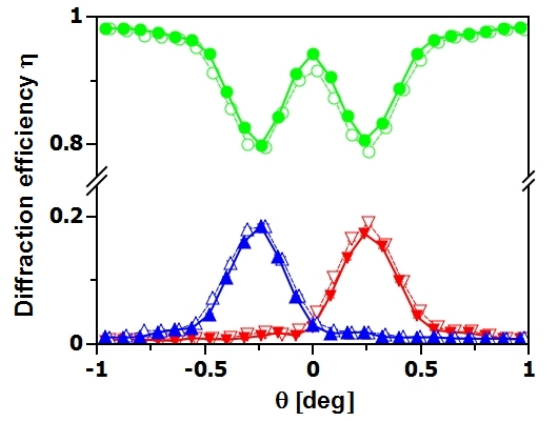
Figure 5. Rocking curves of NP-polymer composite gratings with 20 vol% ( N · · · − 1 st order, l . . . 0 th order, H · · · + 1 st order) and 25 vol% ( △ · · · − 1 st order, # . . . 0 th order, ▽ · · · + 1 st order) SiO NP concentration ( λ ≈ 4 . 5 nm, Λ = 0 . 5 µ m, d 2